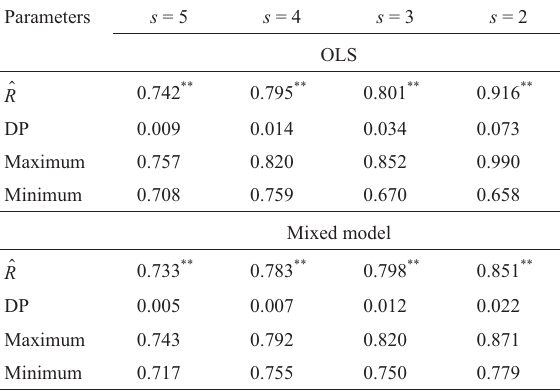
$ Table 2 - Mean values ( R ), associated standard deviations (DP), and maximumandminimumvaluesforthecorrelationcoefficientbetweenthe predicted and observed hybrid means, under different sizes of s 1